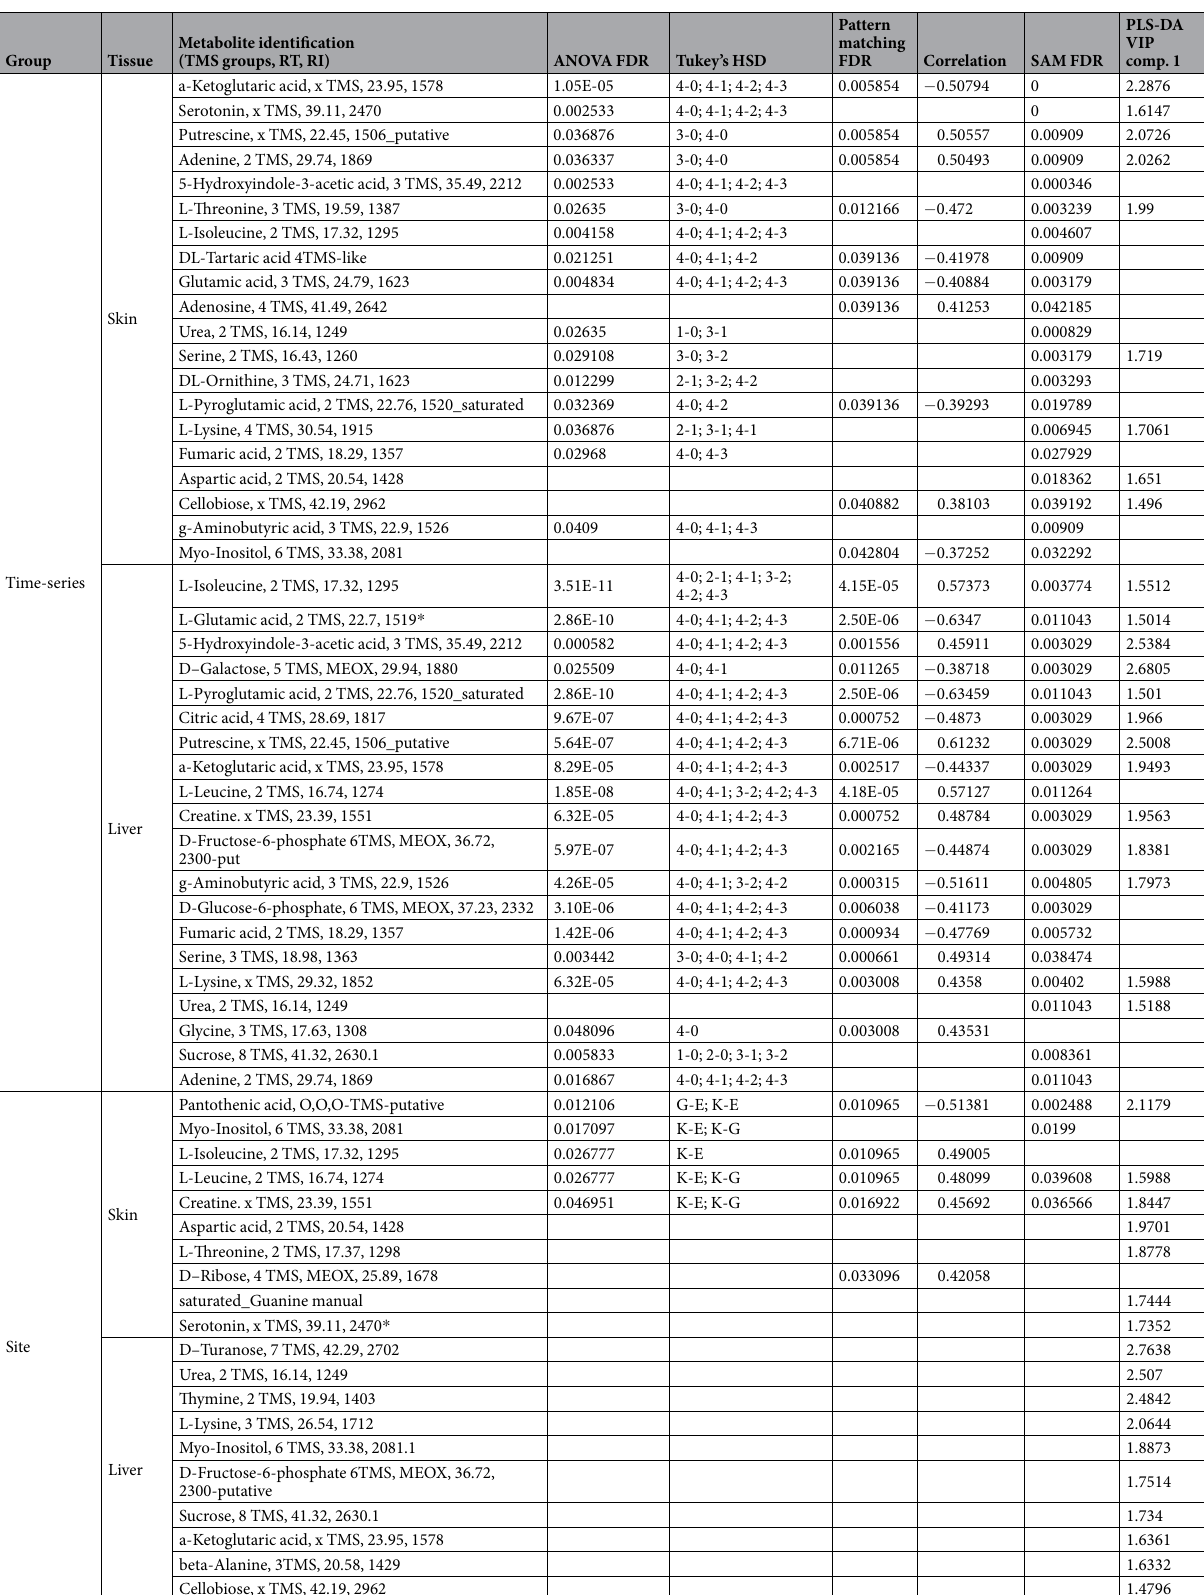
Table 3. Key metabolites in both skin and liver tissues discriminating between experimental groups (including sampling periods post exposure and populations), demonstrating overlap in significant results between univariate (ANOVA, t-test pattern matching and SAM) and multivariate analyses (PLS-DA, top 30 VIP scores ranked on component 1). Comparisons found to be significant with post-hoc Tukey’s HSD tests are listed, as